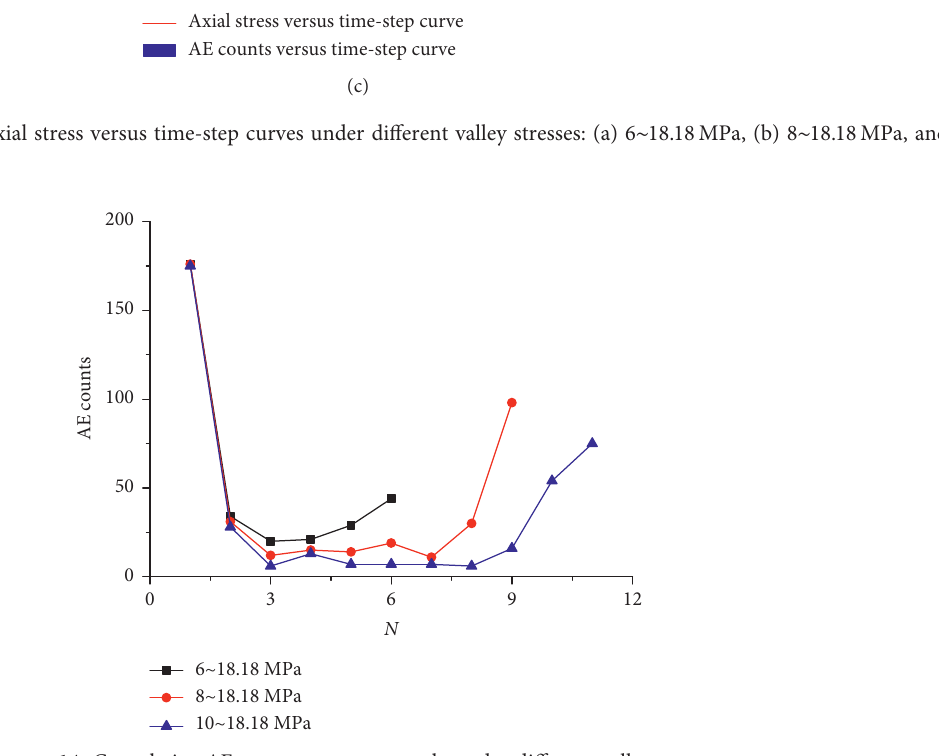
Figure 14: Cumulative AE count curves per cycle under different valley